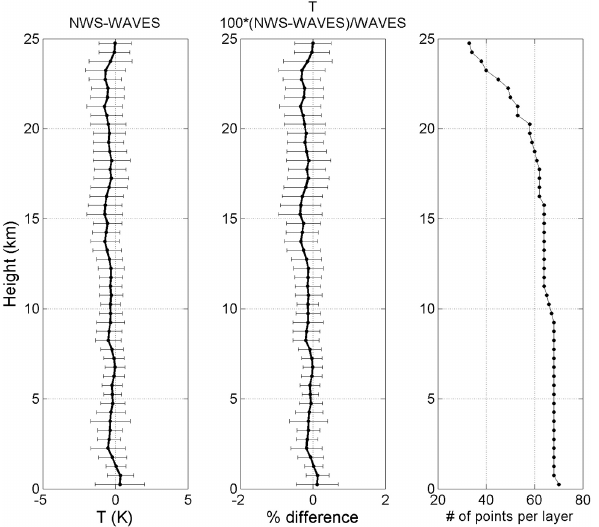
Figure 1. Comparison of radiosonde flights made at Beltsville and NWS-Sterling. Data pairs were matched if they were within 3h. The temperature difference and the standard deviation of the differ- ence are shown as absolute difference and in percent as well as the number of data pairs used at each layer.